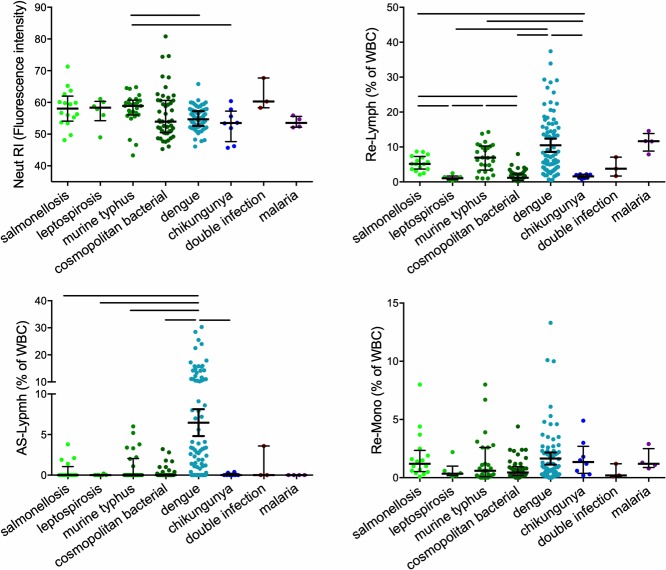
The number or percentage of activated neutrophils (Neut-RI), lymphocytes (Re-Lymph and AS-Lymph), and monocytes (Re-Mono) in patients with a proven infection.The lines indicate median with interquartile ranges. Differences were analyzed using Kruskal Wallis test with post-hoc tests. The lines indicate a statistically significant difference (P<0.05) considering correction of the P value for multiple testing (Benjamini-Hochberg). WBC, white blood cells.